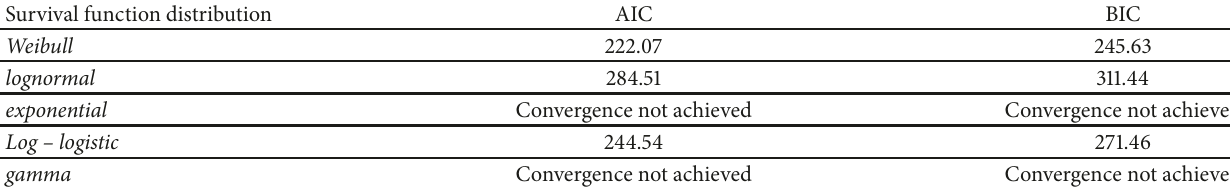
Table 3: Summary of information criteria